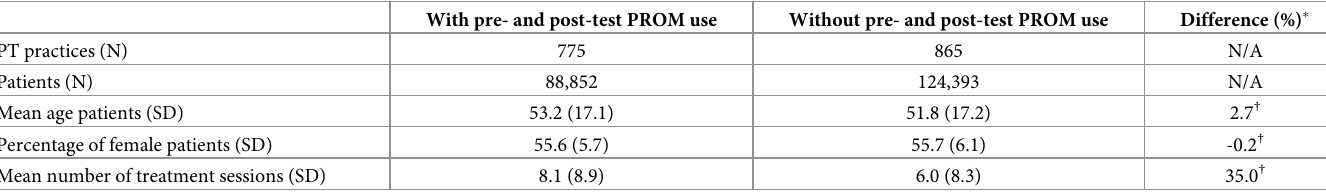
Table 5. Reliability analysis on selection bias using the NSLBP sample of the total clinical registry: A within groups comparison using the availability of a repeated measurement with a PROM (NPRS/ QBPDS/ PSFS) to divide the NSLBP sample in two groups. With pre- and post-test PROM use